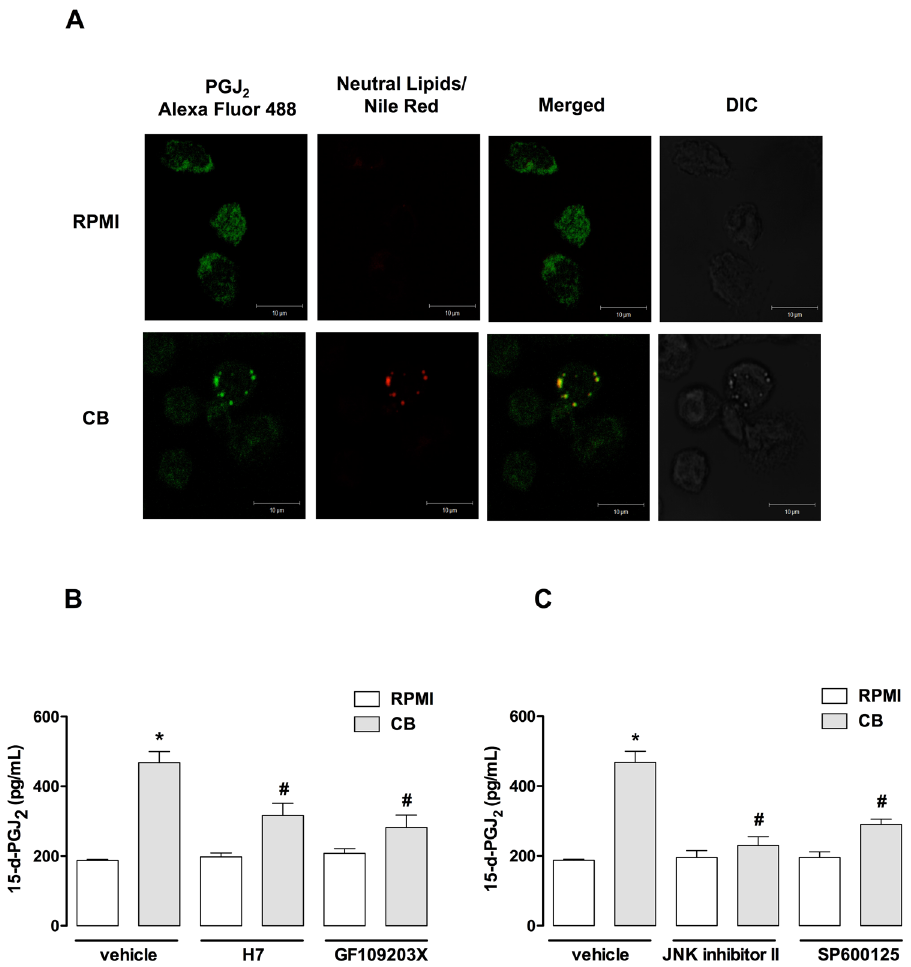
Figure 7. CB-induced cytoplasmic LDs compartmentalize 15-d-PGJ 2 . ( A ) Macrophages incubated with RPMI (control) or CB (0.4 µ M) for 3 h were labeled for LDs (Nile Red) and for 15d-PGJ 2 (anti-15-d-PGJ 2 antibody, Cayman Chemical). The merged image shows colocalization of 15-d-PGJ 2 to LDs. The pictures are representative of three independent experiments. ( B ) Treatment of macrophages with PKC inhibitors H7 (6 µ M) or GF109203X (1 μ M) or (C) with JNK inhibitors JNK inhibitor II (2 μ M) or SP600125 (10 µ M) for 1 h before stimulation with CB (0.4 µ M) or RPMI (control) for 3 h. 15-d-PGJ 2 was quantified by specific EIA. Values represent means ± SEM from 3–4 experiments. * p < 0.05 as compared with vehicle treated RPMI-stimulated cells, # p < 0.05 as compared with vehicle treated CB-stimulated